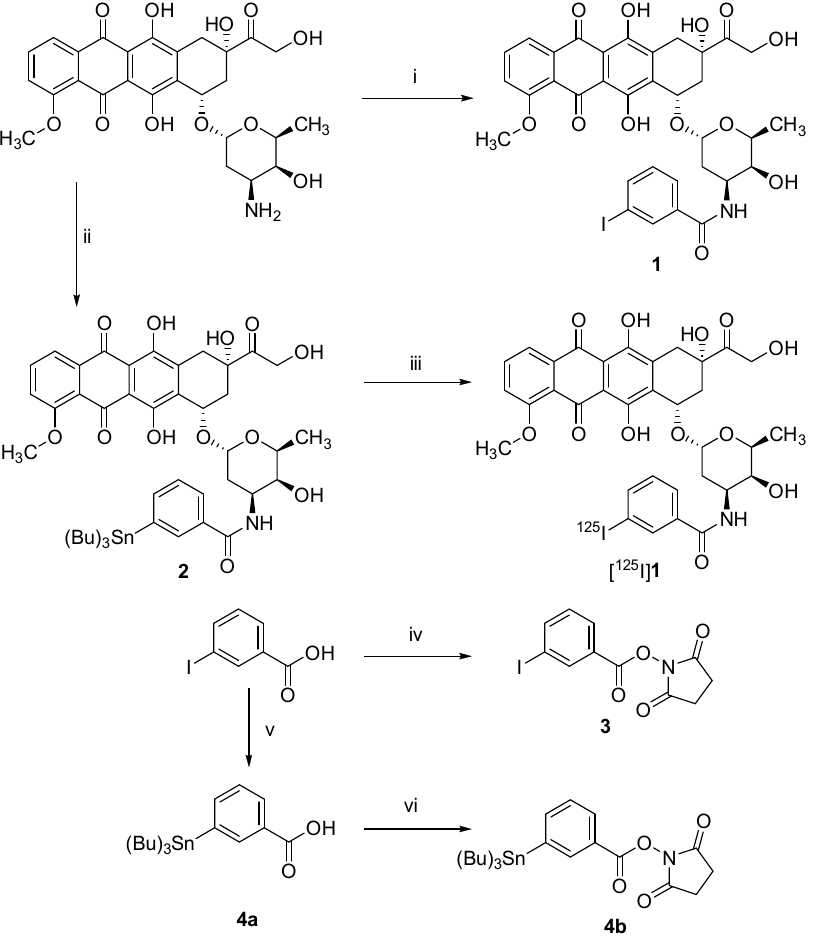
Figure 1. A schematic diagram. Strategy for Auger electron therapy using TSLs and